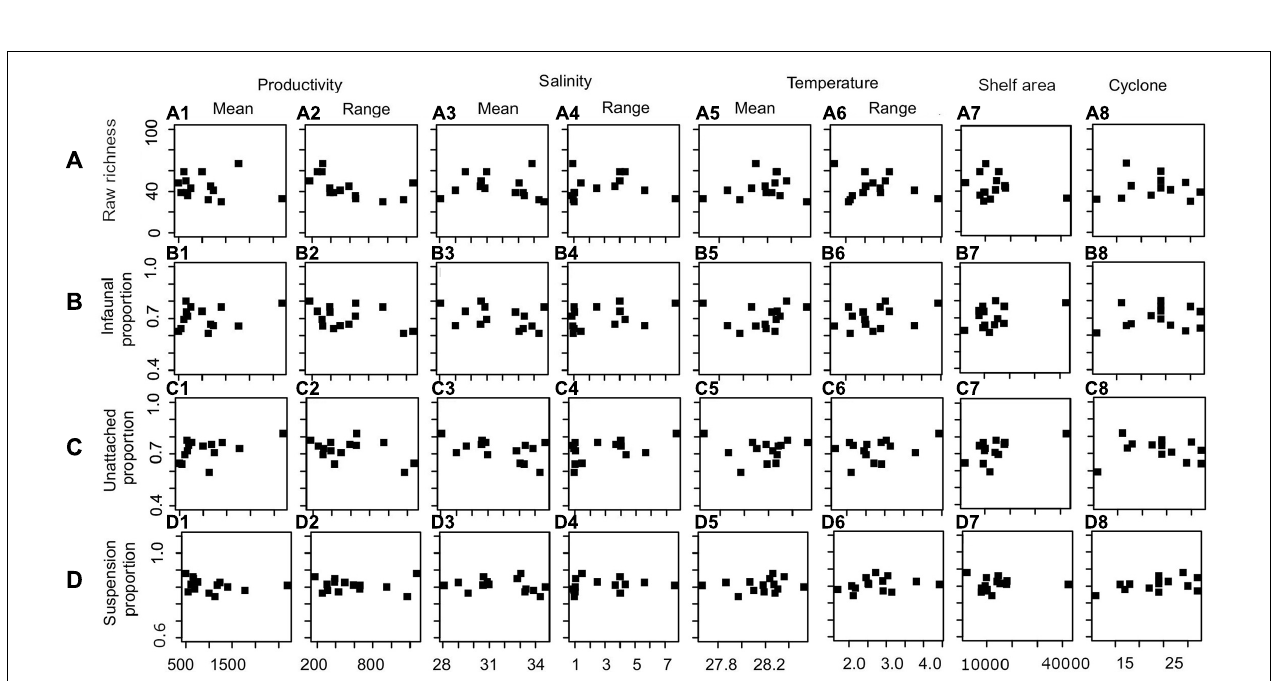
FIGURE 6 | The relationship between oceanographic parameters and species richness (A) , proportion of infauna (B) , unattached (C) , and suspension feeder (D) .